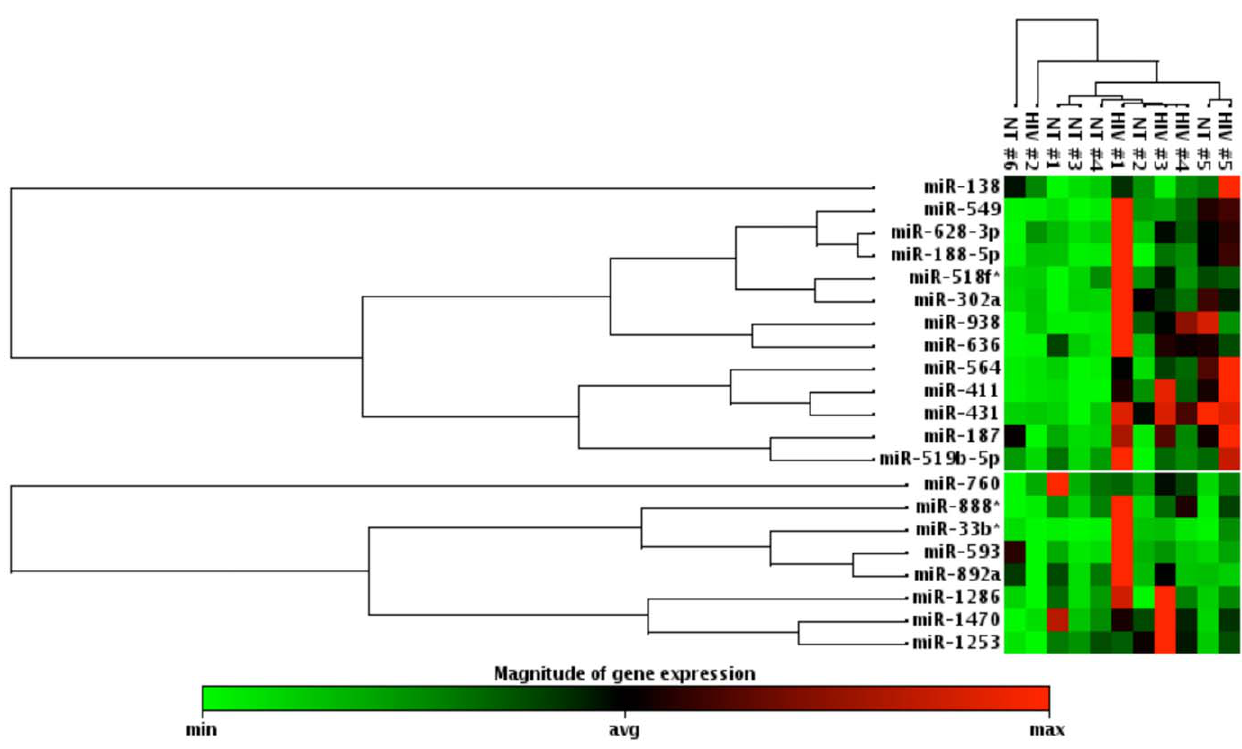
Figure 2. Heatmap and hierarchical clustering of miRNA. The heatmap represents the result of the two-way hierarchical clustering of miRNA and samples. Each row represents miRNA, and each column represents samples tested. The clustering is represented for the miRNA and samples on top and sides, respectively. Red represents miRNA with an expression level above the mean, and green represents miRNA with an expression level below mean/average.